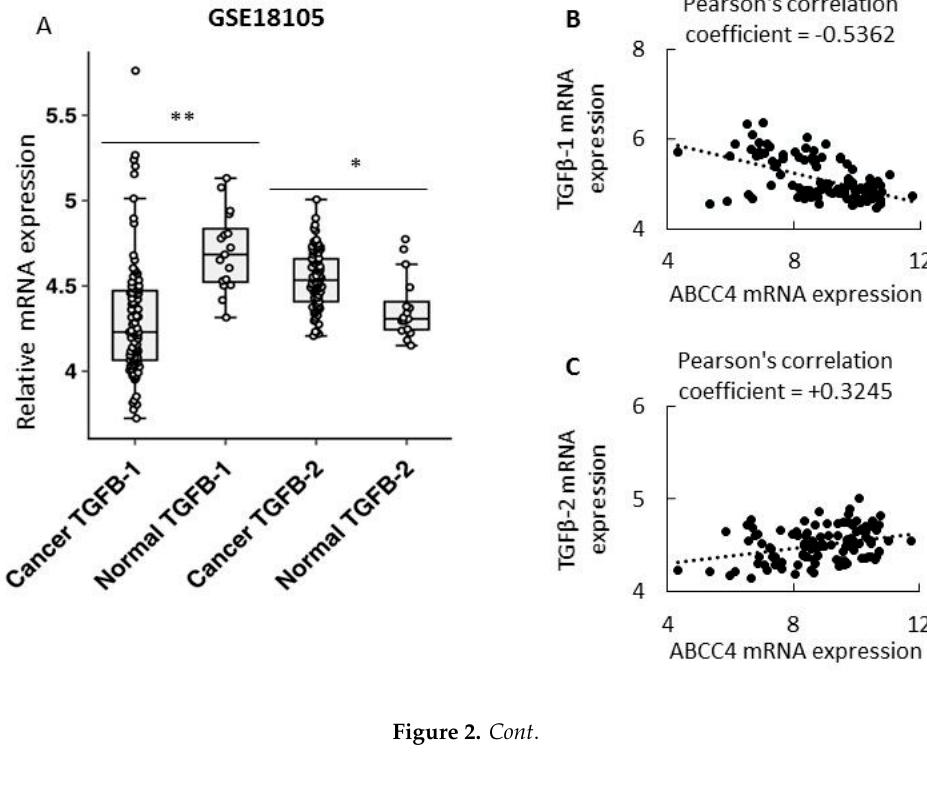
Figure 2. TGF β pathway and ABCC4 mRNA expression analysis. TGF β 1/2 ( A ) and TGF β R1/2 ( D ) expression analysis in CRC patient tissue. Data obtained from the GSE18105 data set, cancer n = 94, normal n = 16. Correlation of ABCC4 expression and TGF β 1 ( B ) or TGF β 2 ( C ) or TGF β R1 ( E ) or TGF β R2 ( F ) expression, n = 110 [20] . Sample data sets were tested with the Shapiro–Wilk test, presenting a normal distribution, followed by the T-test. Pearson’s correlation coefficient (PCC): 0– 0.25 no PCC, 0.25–0.5 low PCC, 0.5–0.75 moderate PCC, 0.75-1 strong PCC. Comparison of Pearson’s and Spearman’s correlation values in Figure S1A, Supplementary Materials. Data density distribution (Figure 2A,D) produced with SinaPlot is presented in Supplementary Materials, Figure S2. * p < 0.05; ** p < 0.005.